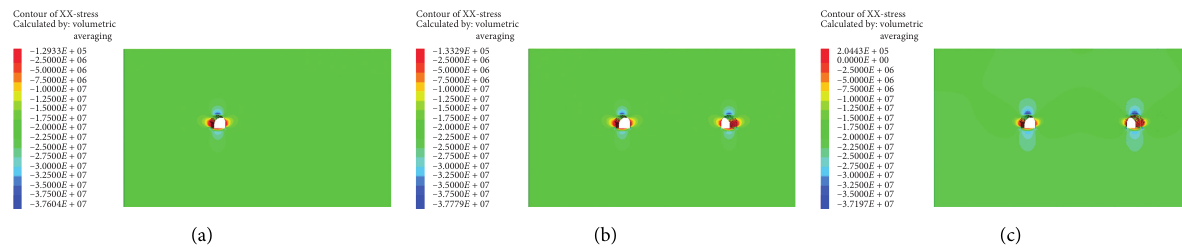
Figure 9: Model principal stress distribution when the roadway moves horizontally for 10m: (a) excavation of the left side roadway, (b) excavation of the right-side roadway, and (c) load seismic wave.